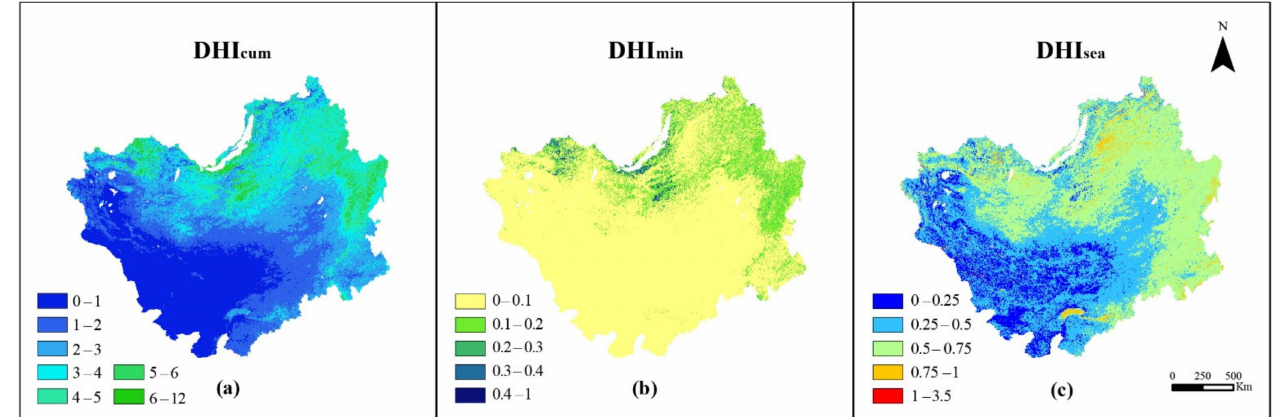
Figure 3. Annual average spatial distribution of DHIs on the Mongolian Plateau from 2001 to 2018: ( a ) DHI cum , ( b ) DHI min , ( c ) DHI sea .